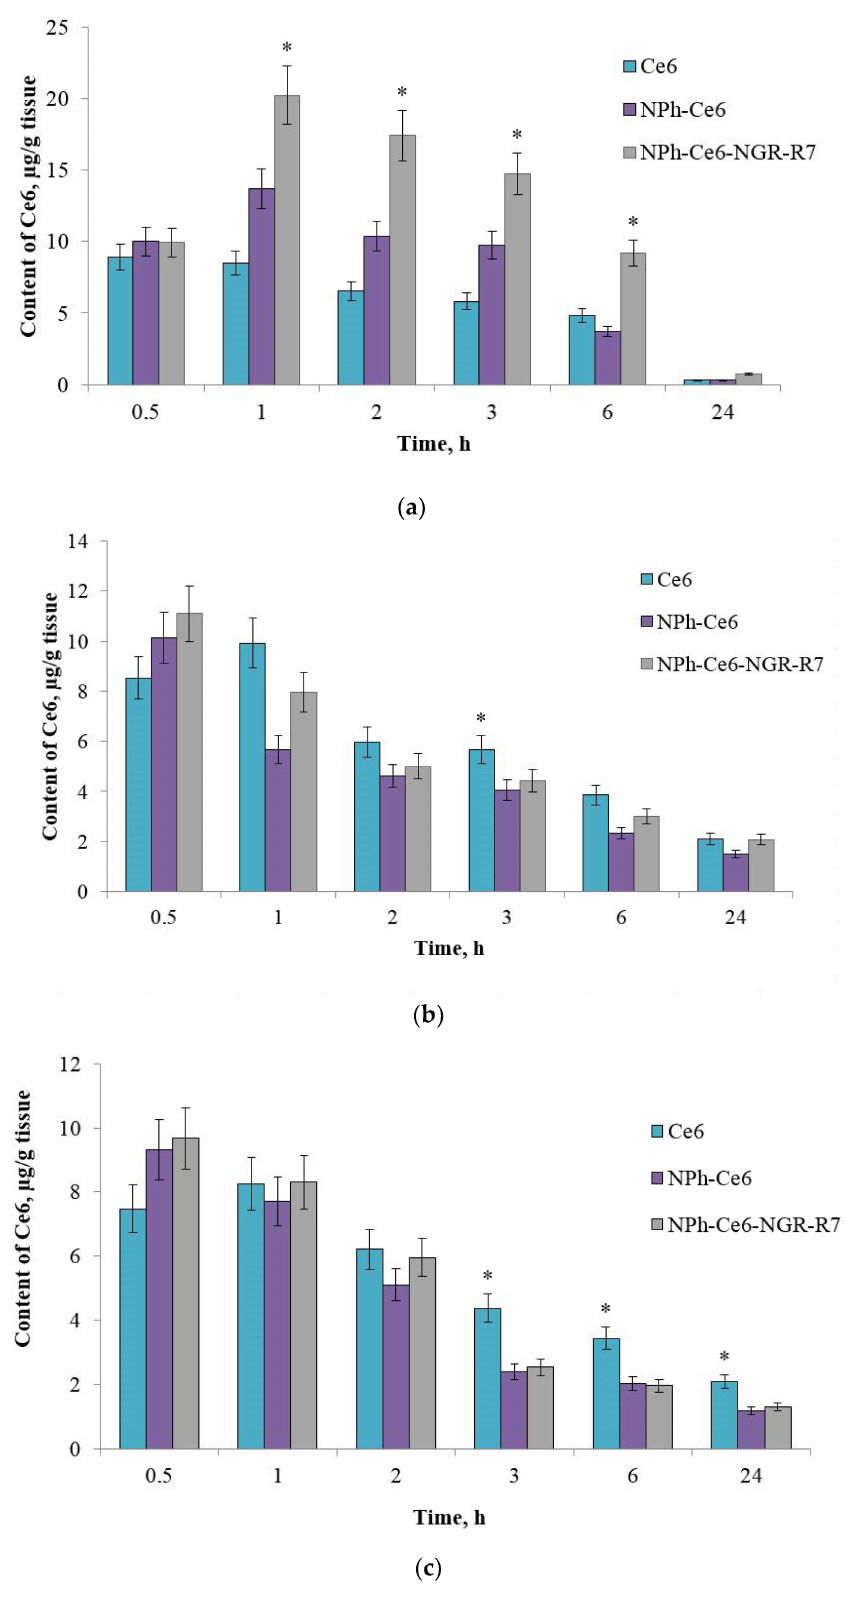
Figure 4. The content of chlorin e6 in tumor tissues ( a ), liver ( b ), and kidneys ( c ) of HT-1080 mice following intravenous administration of the chlorin e6 compositions: free Ce6 substance (blue line), NPh-Ce6 (purple line), NPh-Ce6-NGR-R7 (black dotted line). The dose of Ce6 is 5 mg/kg. * p < 0.05 ( n =